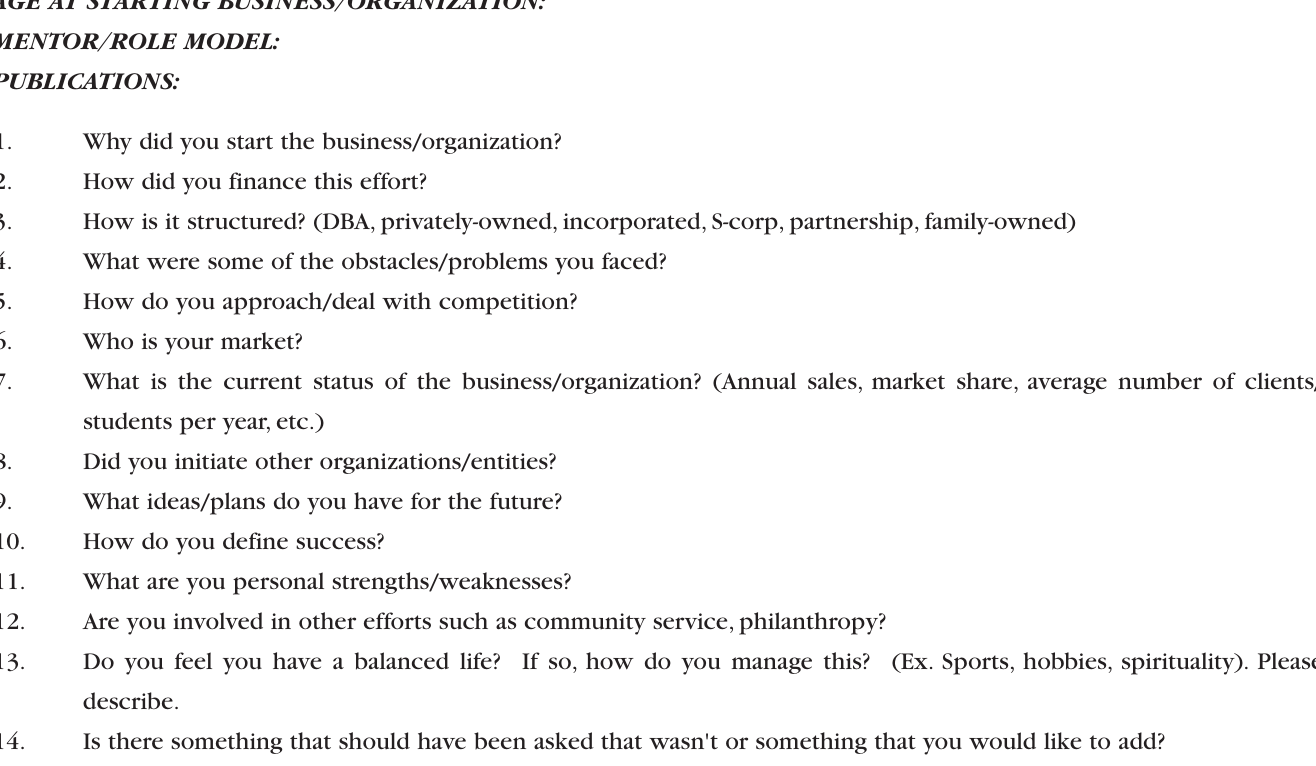
Figure 5. General Format for Uniformity of Research Data